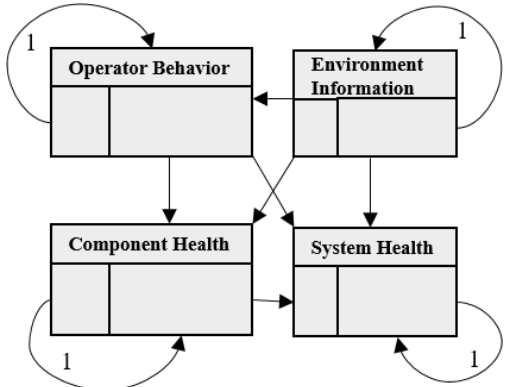
Figure 3. Theoretical DBN construct that indicates the relationships between event/accident data, system information from sensor data, the overall system diagnostics, and prognostics. Additional information about each node could then be used to infer posterior estimates of the other